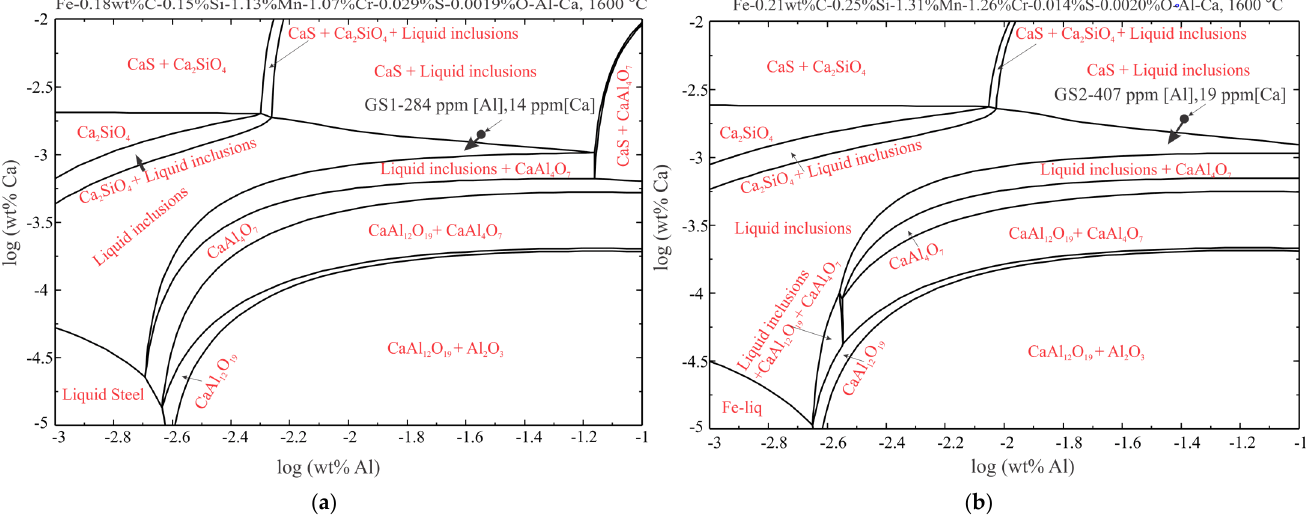
Figure 10. Stability diagram of inclusions formed in the Fe-C-Si-Mn-Cr-S-O-Al-Ca system at 1600 °C. ( a ) GS1 sample, ( b ) GS2 sample.